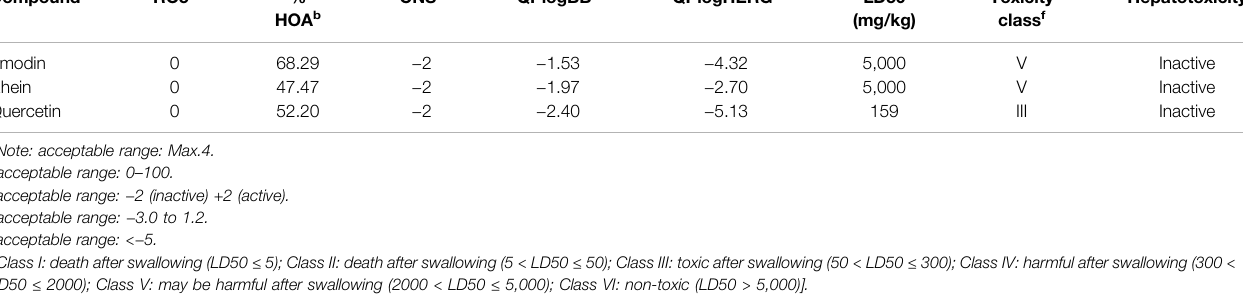
TABLE 4 | Pharmacokinetic properties of the key compounds.